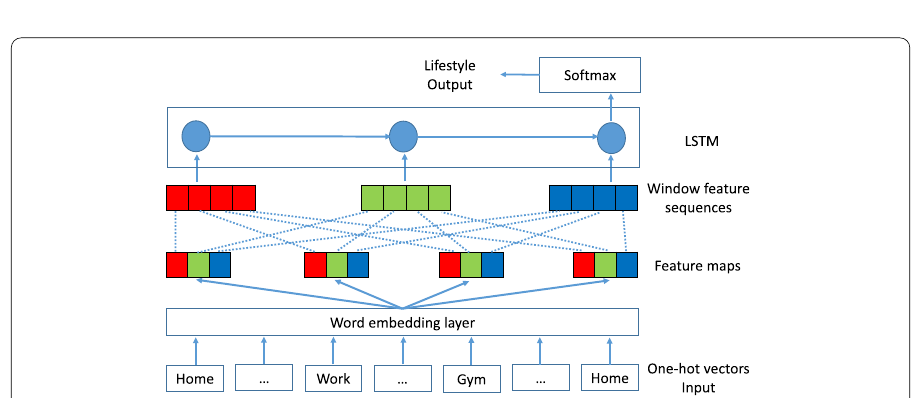
Figure 9 Predicting with CLSTM. The CLSTM model for predicting a lifestyle to trajectory. A one-hot vector has zeros for all trajectories except the specific trajectory (which is one). Each feature in a feature map is represented in a different color (could have more than three